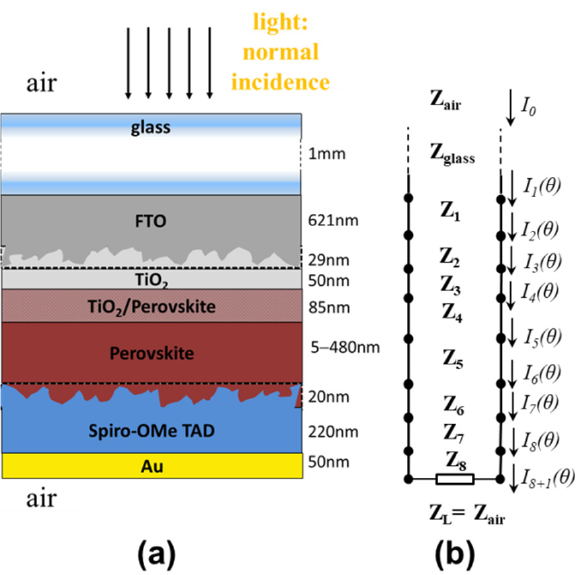
Figure 1. ( a ) The simulated planar photovoltaic structure. ( b ) The equivalent transmission line model.